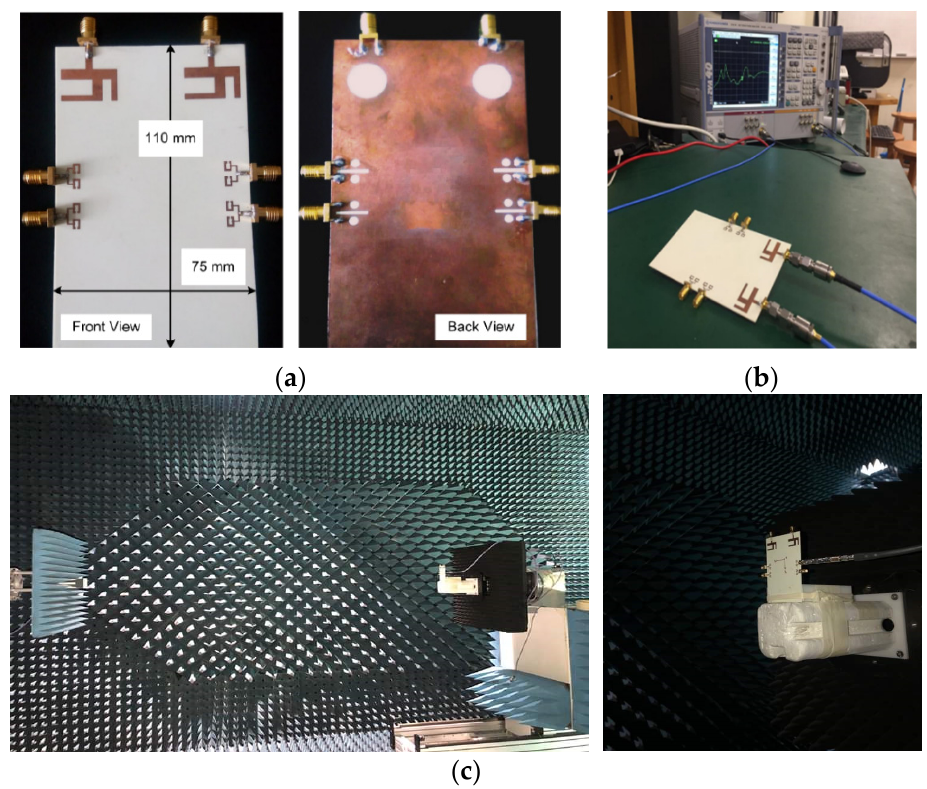
Figure 8. ( a ) Fabricated Prototype, Front and Back View; ( b ) S-parameter measurement with Vector Network Analyzer(VNA); ( c ) Far-field measurement setup.